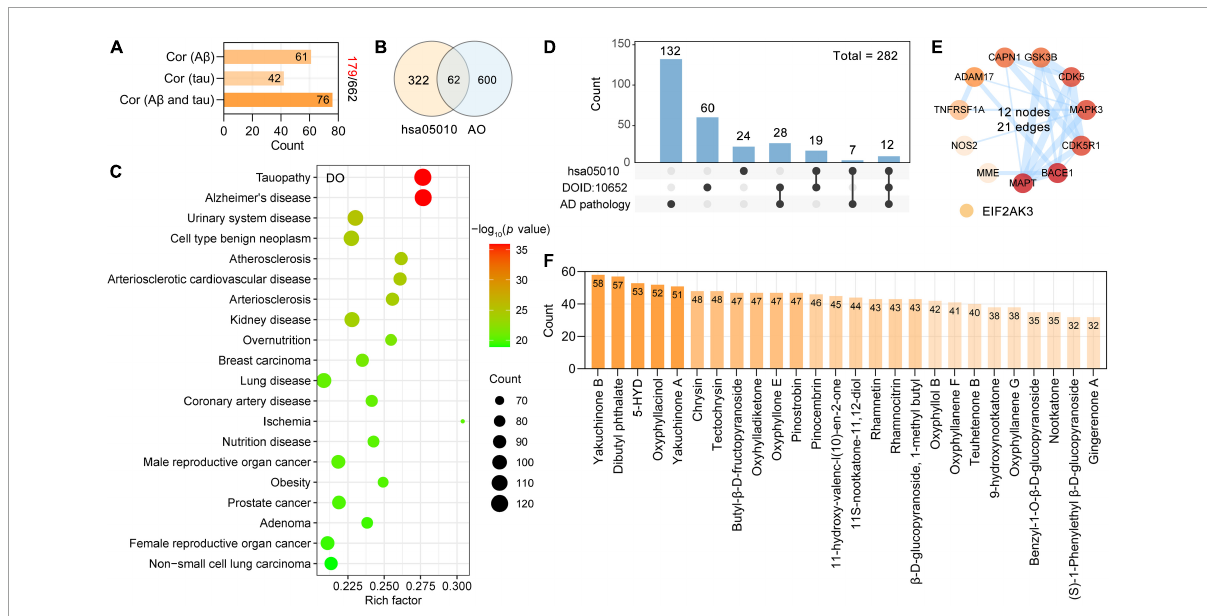
FIGURE4 Screening potential targets of AO against AD and its corresponding phytochemicals. (A) Number of AO targets correlated with A β pathology, tau pathology, A β and tau pathology, respectively. (B) Venn diagram showing overlapping targets between the Alzheimer’s disease (hsa05010) and AO targets. (C) Top 20 significantly enriched Disease Ontology (DO) terms are shown as a bubble diagram. DO terms with corrected p -value < 0.05 were considered significantly enriched. X -axis, rich factor (the ratio of targets in the background terms). Bubble size, the number of genes enriched. Bubble color, –Log 10 ( p -value). (D) UpSetR plot highlights the intersection of AO targets associated with AD pathology, Alzheimer’s disease (hsa05010) and Alzheimer’s disease (DOID: 10652). (E) PPI network of 12 anti-AD targets related to AD